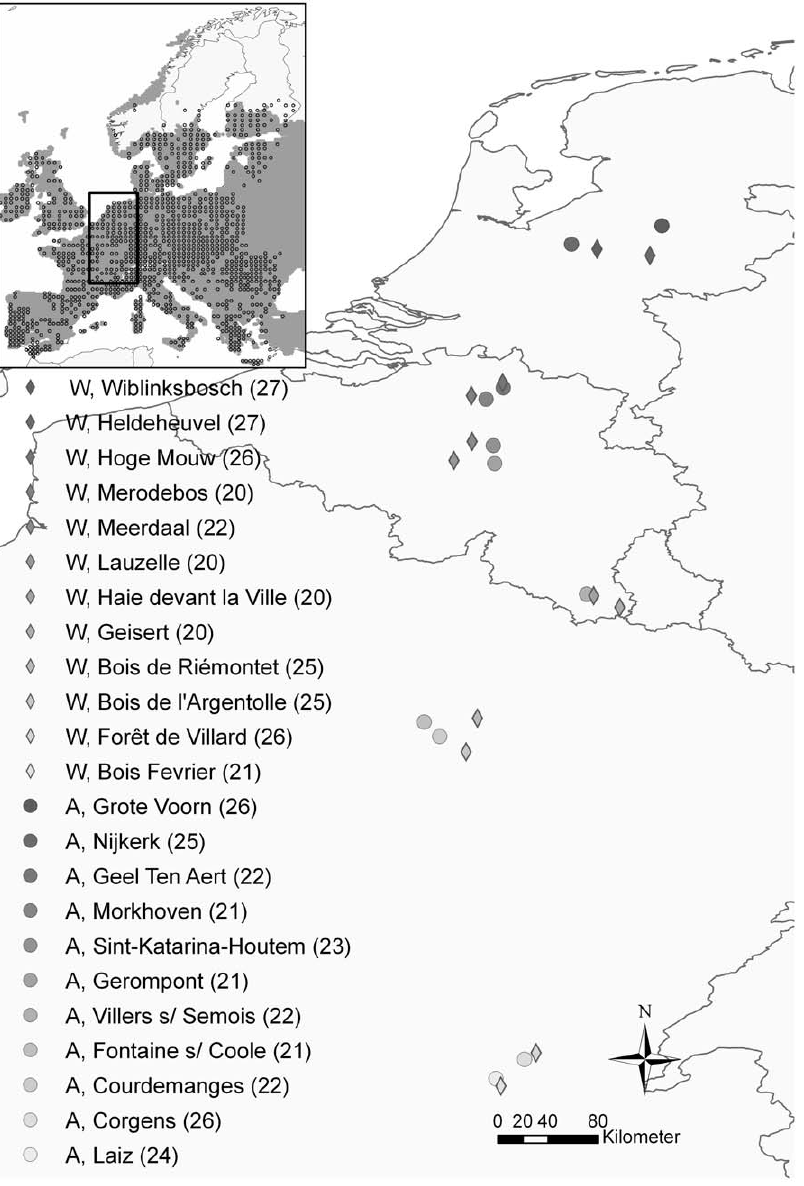
N , A). Sample sizes are indicated between brackets after